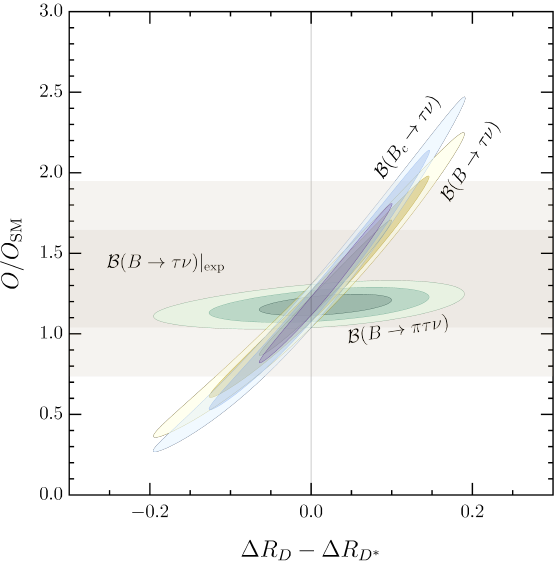
Figure 3. Predictions for B ( ¯ B c → τ ¯ ν ), B ( ¯ B u → τ ¯ ν ) and B ( ¯ B → πτ ¯ ν ), all normalized to the corresponding SM expectations, as a function of ∆ R D − ∆ R D ∗ . In gray, the experimental value of B ( ¯ B u → τ ¯ ν ) at 1 σ and 2 σ